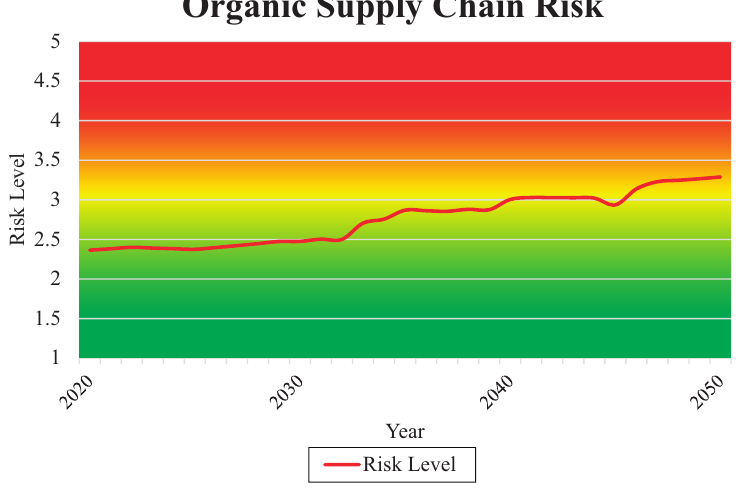
Figure 10. Possible organic